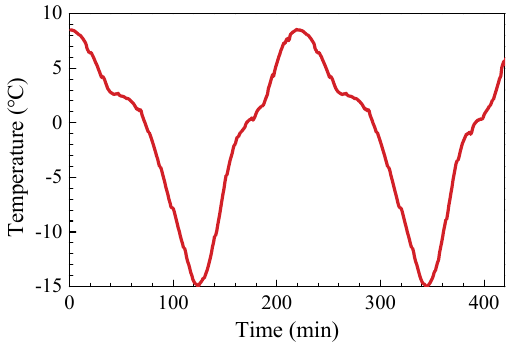
Figure 3. Internal temperature of notched beam in freeze–thaw cycles.